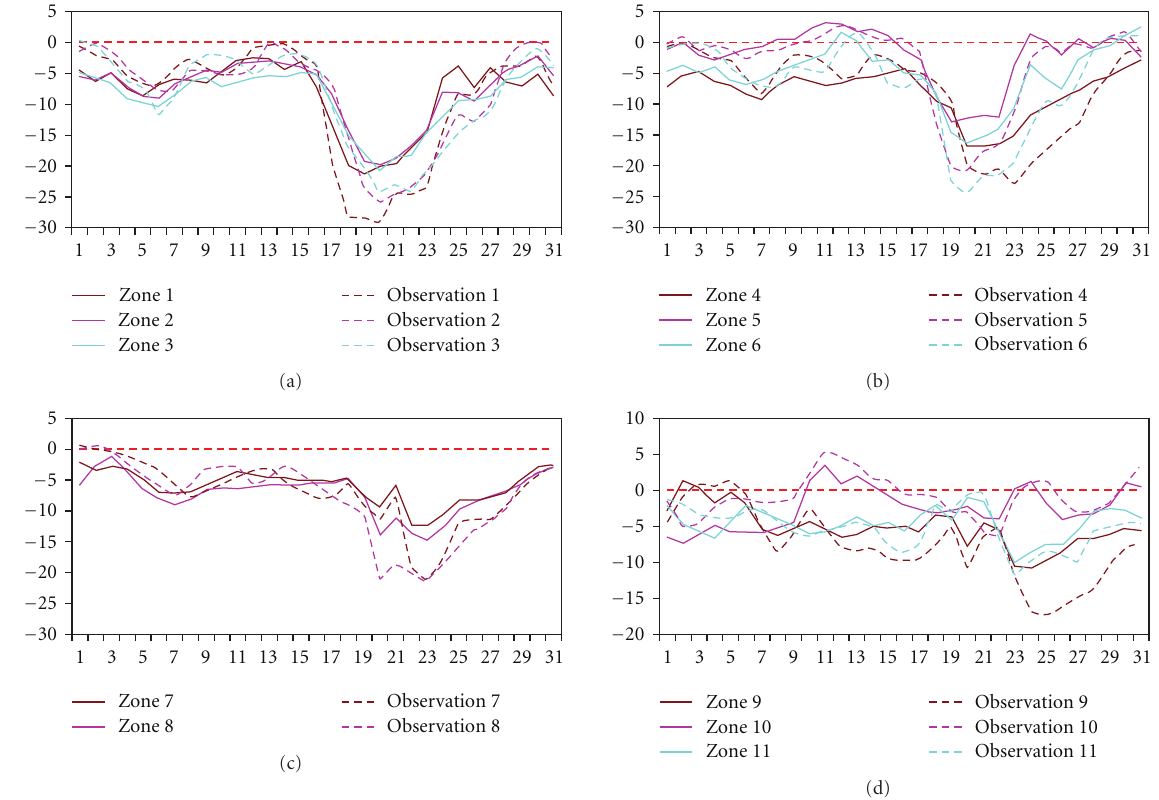
Figure 4: Time series of the daily mean area averaged temperature (C) at 2 m height for di ff erent zones along with the averaged station daily mean surface temperature for corresponding